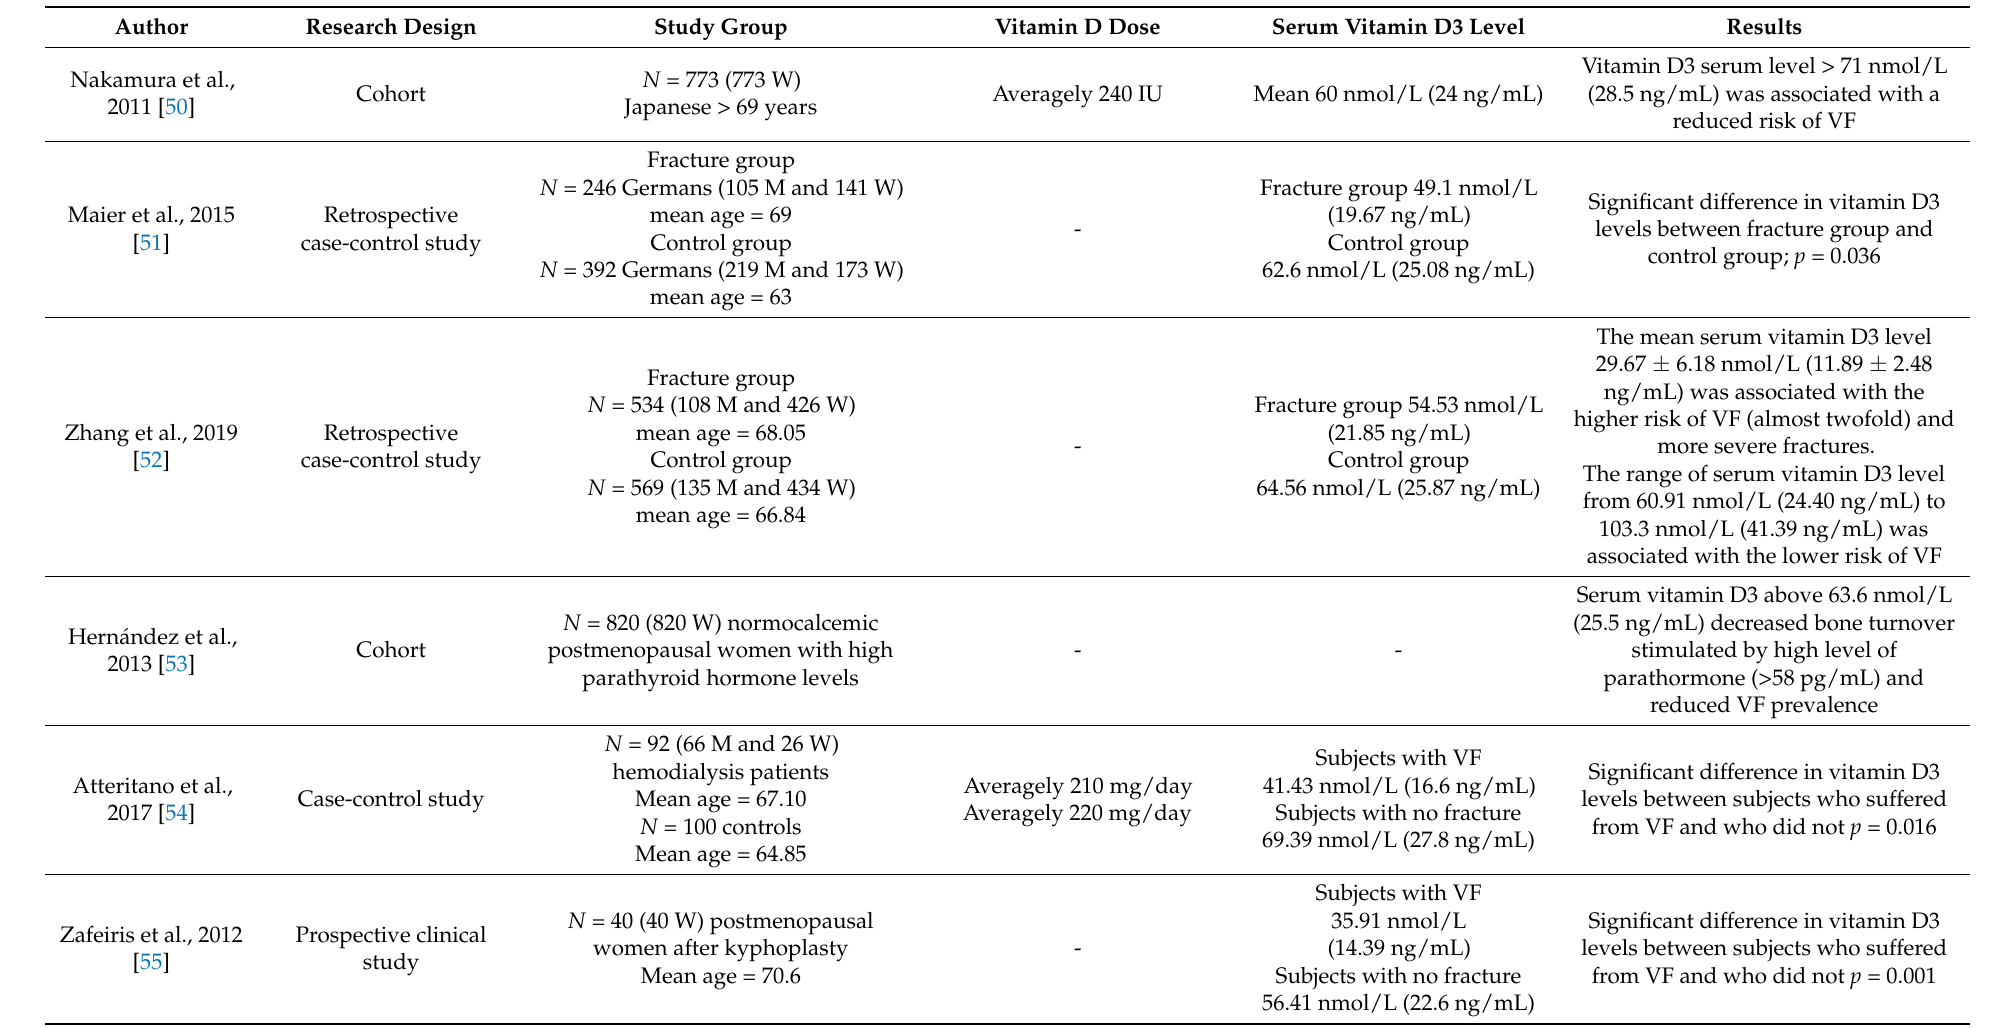
Table 1. Vitamin D supplementation and vertebral fractures—single